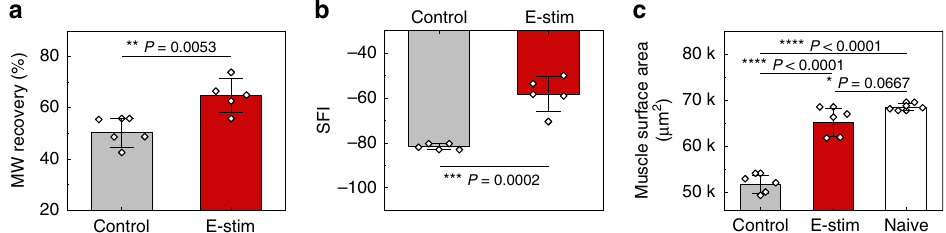
Fig. 6 Early protective mechanism by a single episode of distal nerve stimulation 12 days after denervation injury. a Relative muscle weight (MW) reveals a signi fi cant preservation of gastrocnemius muscle mass following a single episode of distal nerve stimulation. b Dynamic gait analysis reveals that the sciatic function index (SFI) is signi fi cantly preserved by this single stimulation. c Hematoxylin and Eosin (H&E) staining of the affected gastrocnemius muscle fi ber reveals an improved maintenance of muscle fi ber surface area by single stimulation. In a , b , and c the results are shown as means± s.e.m ( n = 5 biologically independent animals per groups). Statistical software (Version 6.0) was used for analysis followed by a t -test and one-way ANOVA with Tukey multiple comparison analysis (* P < 0.05; ** P < 0.01; *** P < 0.001; **** P < 0.0001). Data available in source data fi